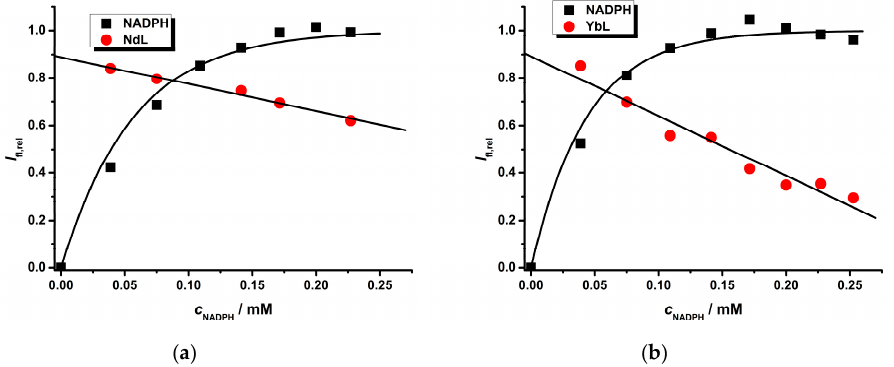
Figure 5. The quenching effect of NADPH on luminescence intensity of ternary Nd(III) ( a ) and Yb(III) ( b ) complexes with DO3A macrocyclic and IQCA ligands ( exc = 325 nm, pH = 7.5 (40 mM HEPES), c Ln ∼ 0.2 mM, c DO3A ∼ 0.35 mM, c IQCA ∼ 0.2 mM). em_NADPH = 460 nm, em_NdL = 880 nm, em_YbL = 980 nm. Table 1. The quenching effect of NADPH on Ln(III) complexes.